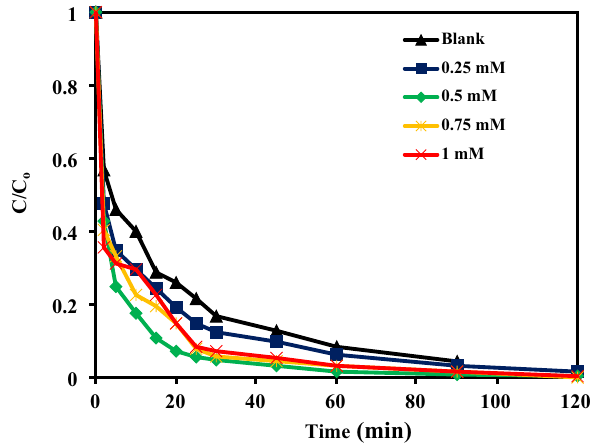
Figure 8. ( a ) Effect of the addition of different concentrations of H 2 O 2 on the removal efficiency of Cr(VI) at NZVI-Si dose of 0.1 g/100 mL, initial Cr(VI) concentration of 25 mg/L, contact time of 120 min, and temperature of 20